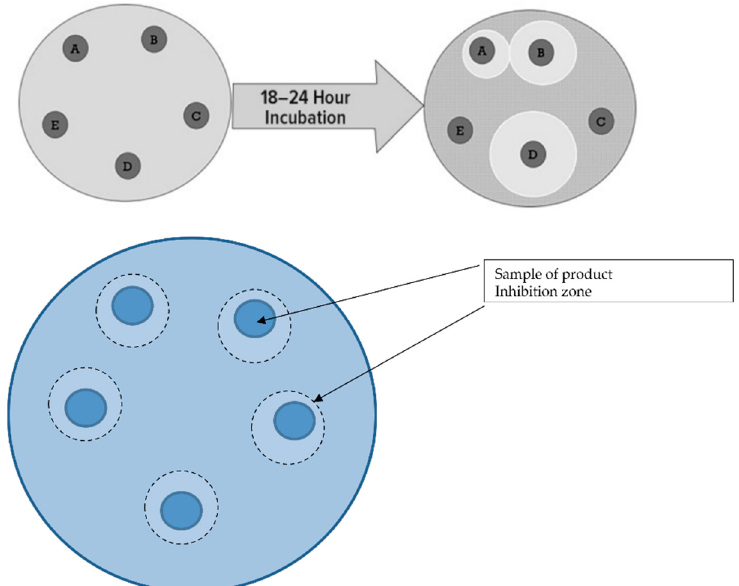
Figure 1. Schematic of the culture medium for pathological bacteria and probiotic market products. Explanation: product A ( Lactobacillus helveticus, Lactococcus lactis, Bifidobacterium longum, Bifidobacterium breve, Lactobacillus rhamnosus, Strepto-coccus thermophilus, Bifidobacterium bifidum, Lactobacillus casei, Lactobacillus plantarum ), product B ( Lactobacillus plantarum ), product C (4 Lactobacillis, 2 Bifidobacterium , Lactococcus lactis ), product D ( Lactobacillus rhamnosus ), product E (4 Lactobacillis 3 Bifidobacterium, Streptococcus thermophilus ).